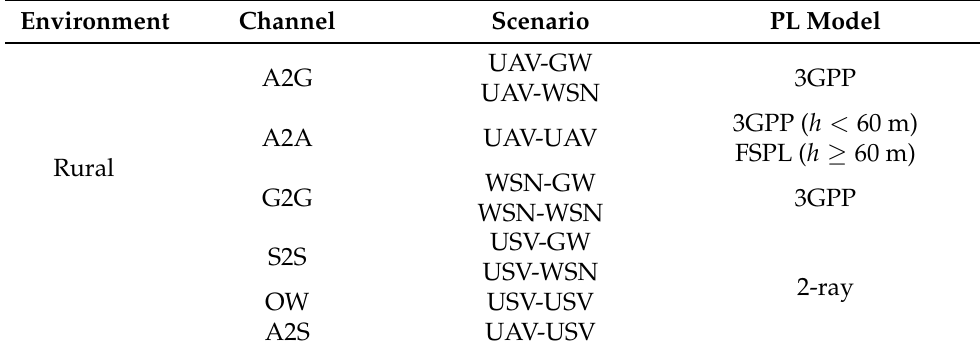
Table 7. Proposed environment, channels, scenarios and path loss models for aerial, terrestrial and water communications.